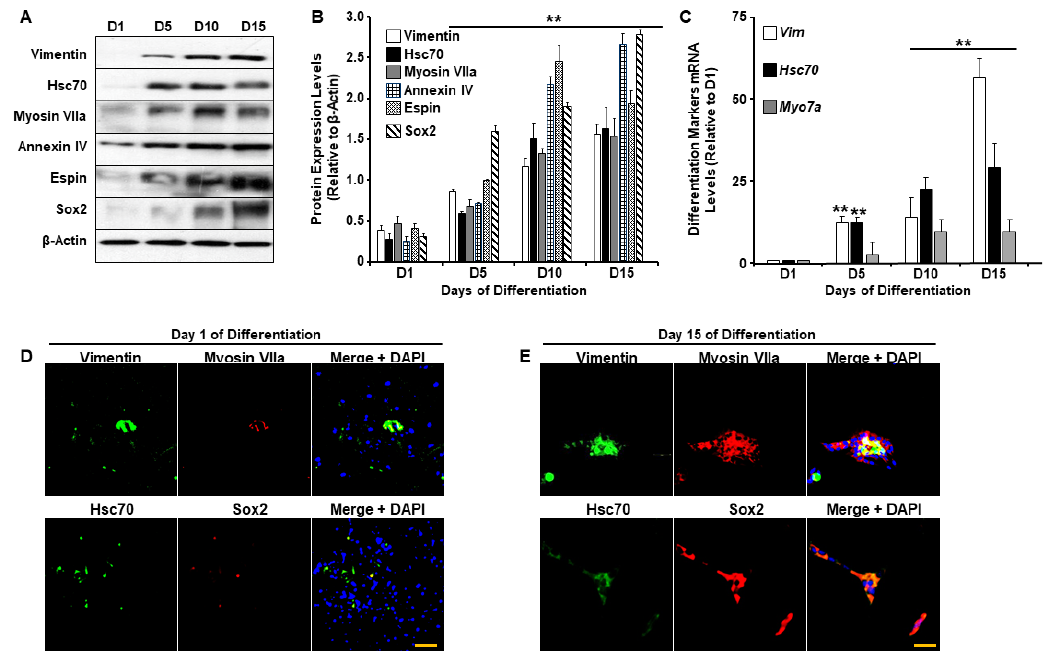
Figure 1. UB/OC−2 cells differentiate into sensory hair cells . ( A , B ) Representative immunoblots ( A ) and bar graph quantitative assessment ( B ) of Vimentin, Hsc70, Myosin VIIa, Espin, Annexin IV, and Sox2 in total cell lysates from UB/OC−2 during differentiation. Data is representative of at least three independent experiments. ( C ) mRNA levels of differentiation markers Vim , Hsc70 , and Myo7a . Data are normalized to Tbp and are representative of at least three independent experiments. In ( B , C ), ** p < 0.01 indicates a significant difference between cells on the indicated day of differentiation (D5, D10, or D15) and undifferentiated cells (D1). ( D , E ) Immunofluorescence of Vimentin, Hsc70 (green fluorescence), Sox2, Myosin VIIa (red fluorescence), and nuclear DNA using DAPI (blue fluorescence) in undifferentiated (Day 1; ( D )) and differentiated (Day 15; ( E )) UB/OC−2 cells. Scale bar = 100 μm.